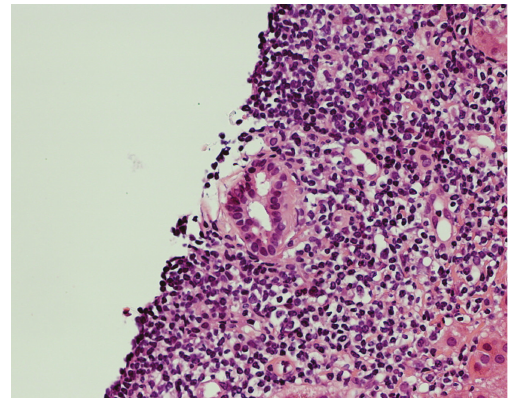
Figure 4: Atrophic interlobular bile duct (high-power